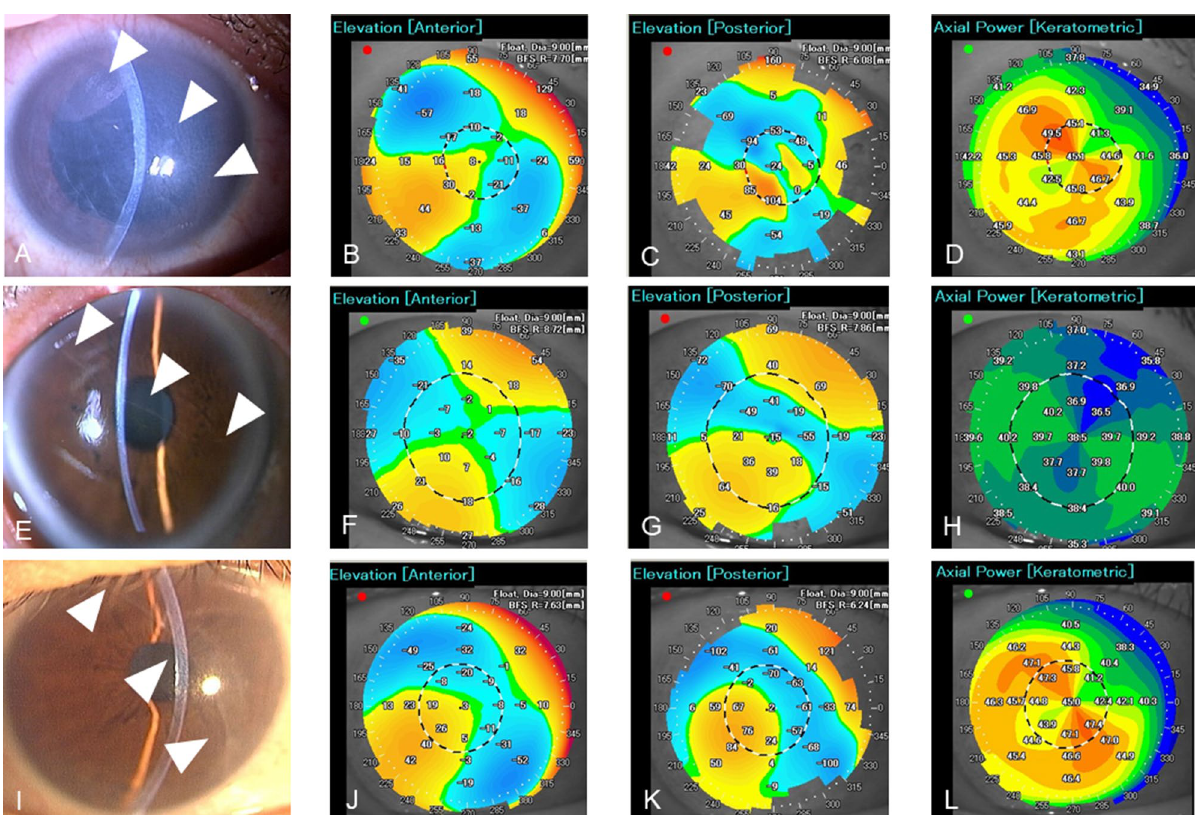
Figure 1. Direction of Descemet break and astigmatism axis. Case1 ( A – D ) is a 51-year-old woman, a Descemet membrane (DM) break appears obliquely present ( A : arrow heads). Case2 ( E – H ) is a 69-year-old man, a Descemet membrane (DM) break appears horizontal present ( E : arrow heads). Case 3 ( I – L ) is a 67-year-old woman, a Descemet membrane (DM) break appears vertical present (I: arrow heads). The topographic elevation map shows a blue area on the anterior ( B , F , J ) and posterior corneal surfaces ( C , G , K ) in the area with the DM break ( A , E , I ). Those blue areas are associated with the corneal astigmatism axis ( D , H , L ). In the current study, the direction of the DM breaks was identical to that of the corneal astigmatism axis in 14 of 23 eyes